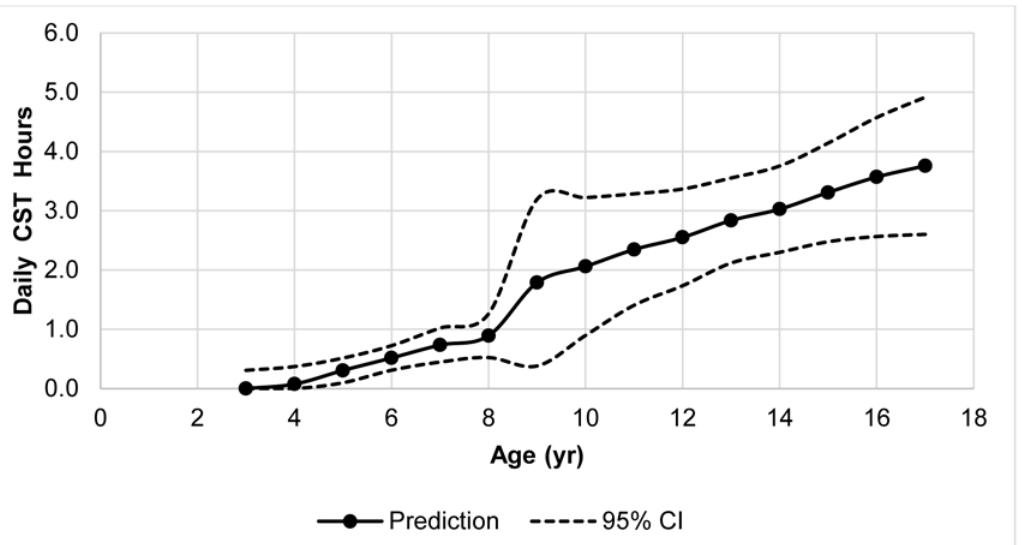
Fig 1. Predicted average daily computer screen time hours based on the normal group age regression model. CST – Computer screen time.